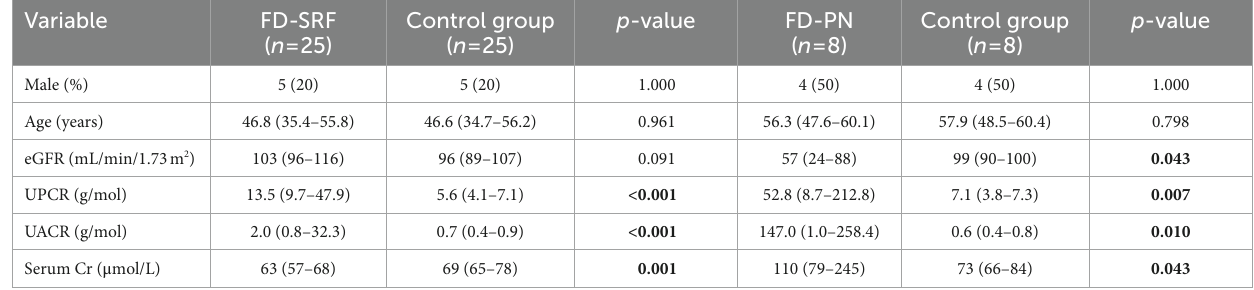
TABLE 2 Validation cohort characteristics.